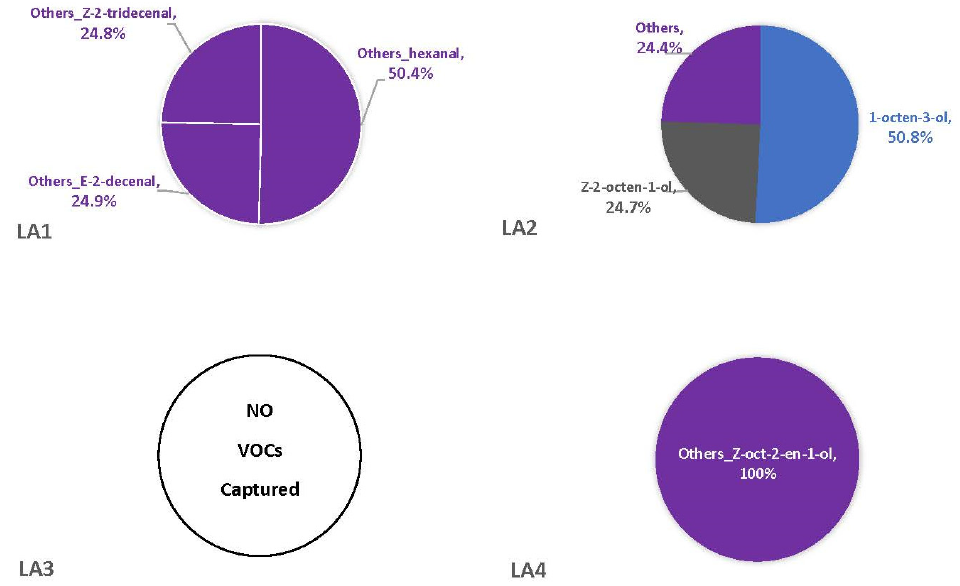
Figure 4. Average percentages (over three replicates) of VOCs contributing to total headspace profile of each Aspergillus strain while growing on CMA medium.